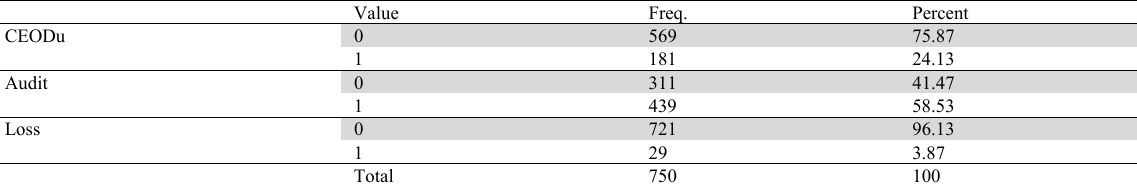
The distribution of CEODu, Audit and Loss variable in the sample